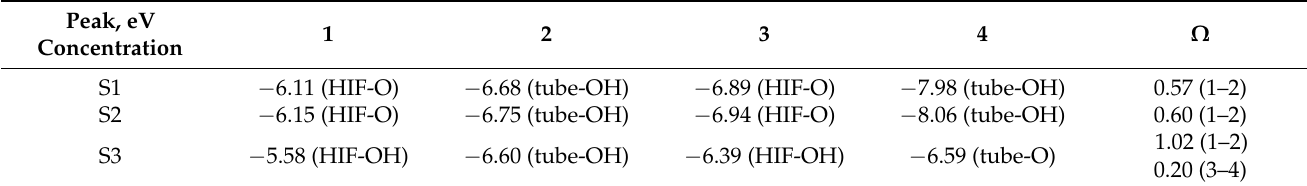
Table 4. Positions of PDOS peaks for HIF-1 α and carboxyl.